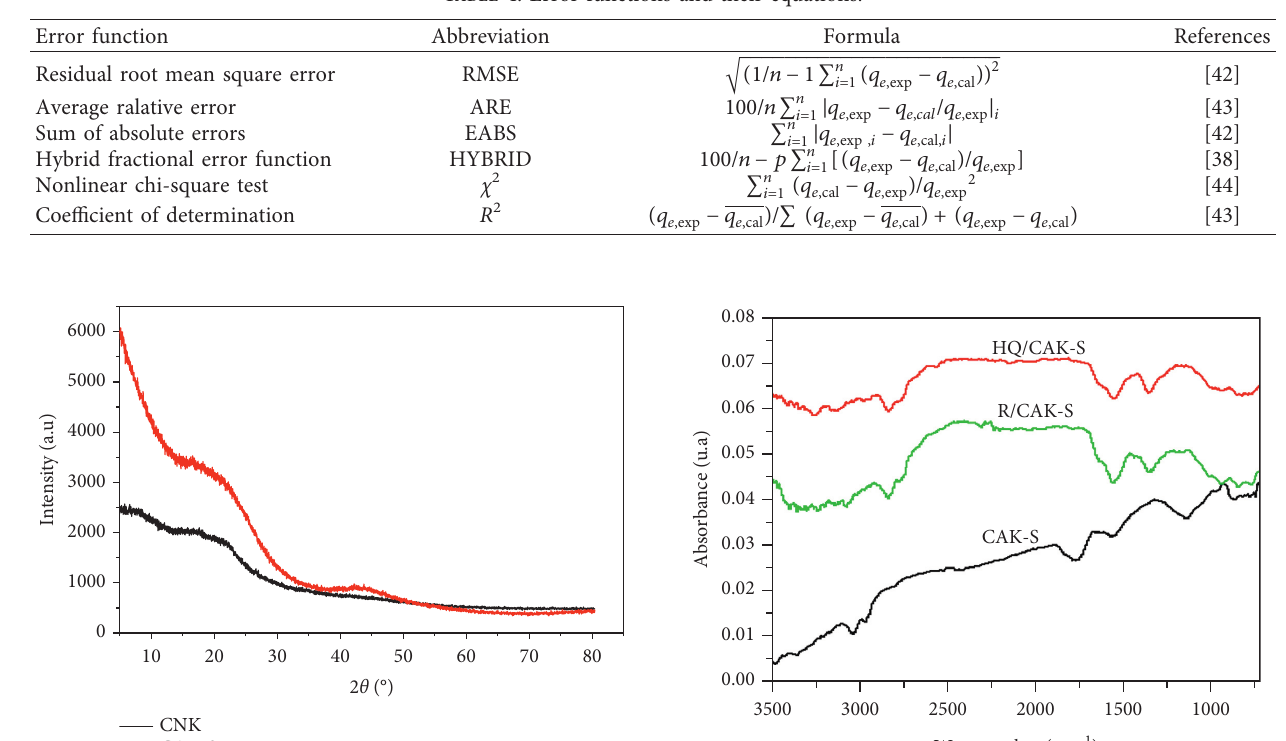
Table 4: Error functions and their equations.